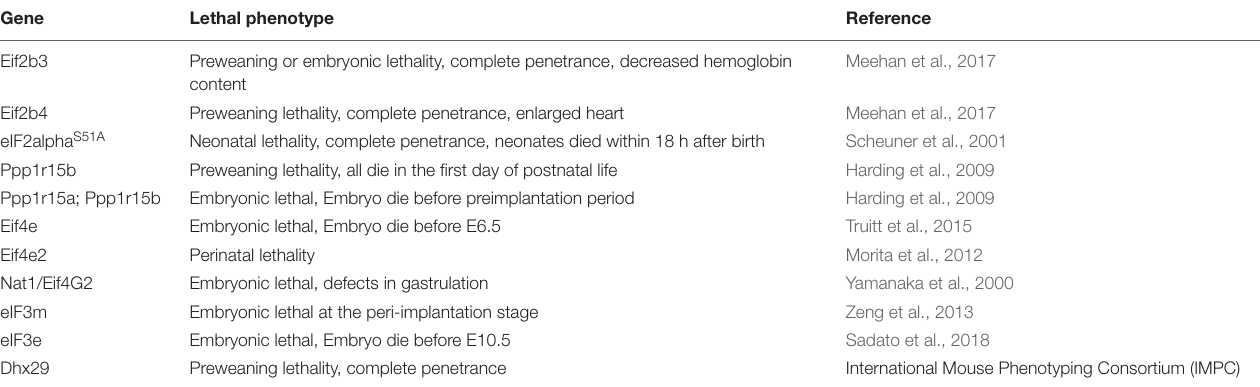
TABLE 1 | Lethal phenotypes resulting from change in activity or lack of eIFs in mouse.